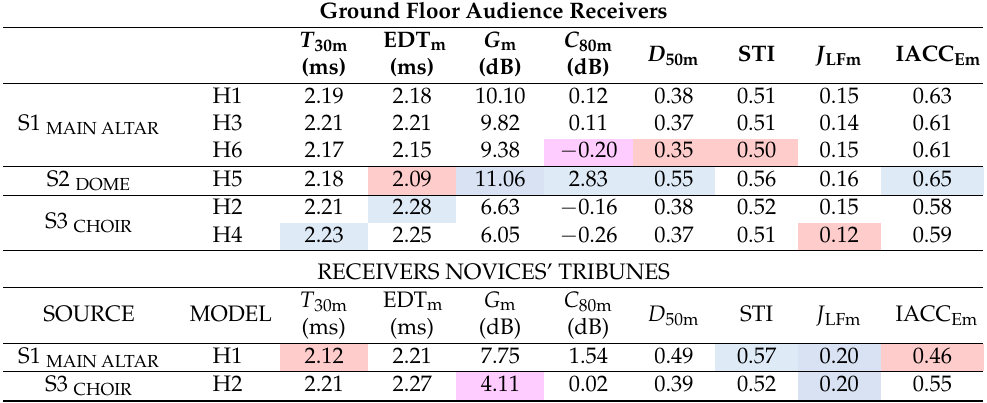
Table 8. Unique number values for sources S1 (main altar), S2 (dome) and S3 (choir) in the different